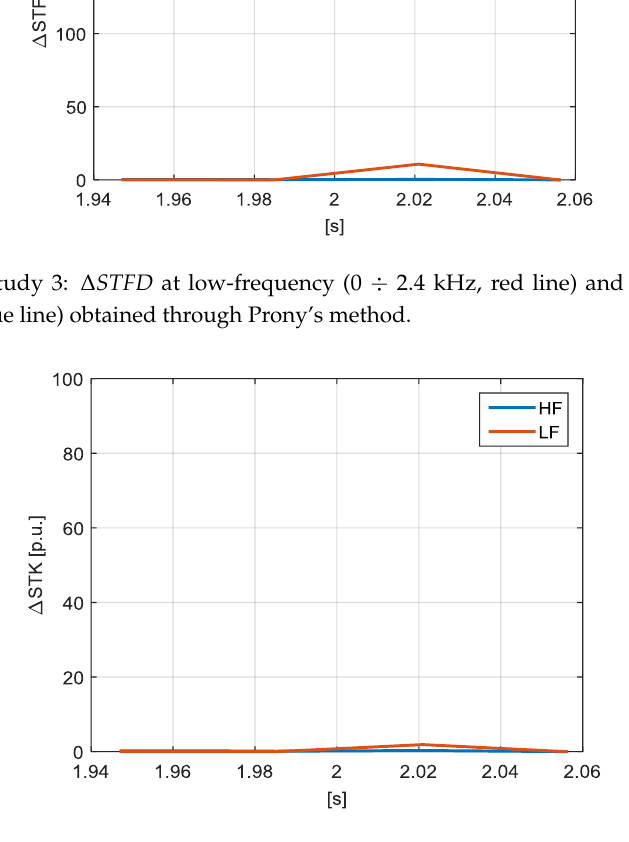
Figure 42. Case study 3: Δ STK at low-frequency (0 ÷ 2.4 kHz, red line) and at high-frequency (2.4 ÷ 150 kHz, blue line) obtained through Prony’s method.